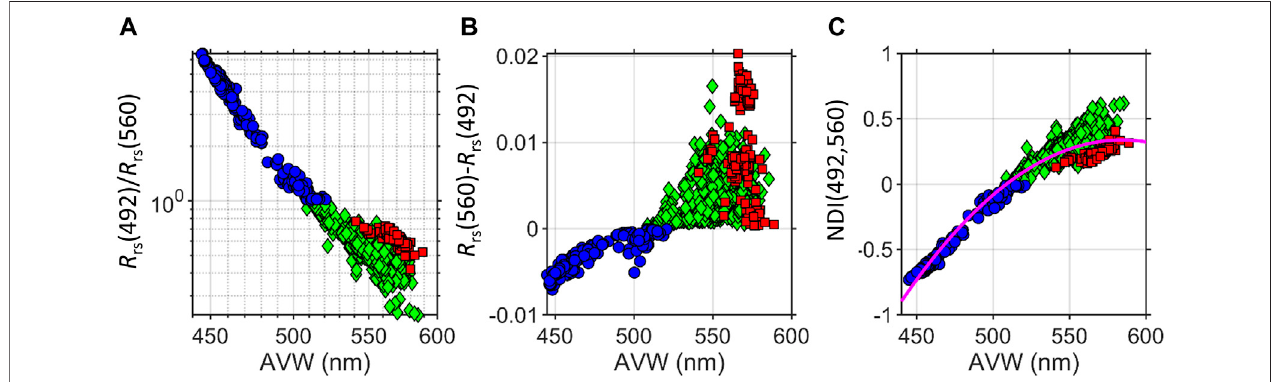
FIGURE 3 | Examples of different spectral band math approaches compared to Apparent Visible Wavelength (AVW) evaluated with the CASCK-P training dataset separated by water type: Blue-green (blue circles), Green (green diamonds) and Brown (red squares). Approaches include (A) Band ratios (B) Band differences and (C) Normalized Difference Indices (NDIs) with different band combinations. These approaches were not selected for use due to overall fi t and divergence of data from different water